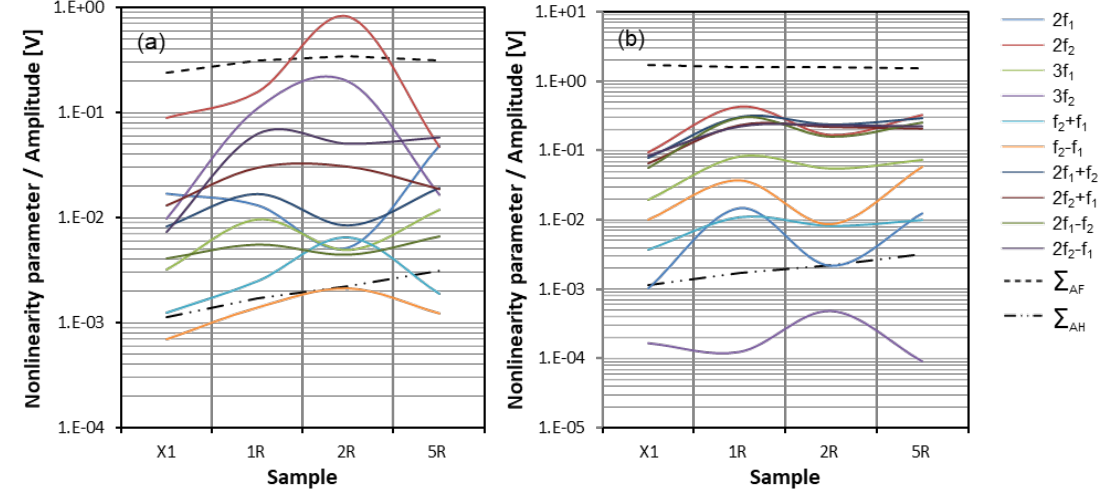
Figure 20. Nonlinearity parameter: ( a ) f 1 = 3 MHz, f 2 = 5 MHz, α = 60°; ( b ) f 1 = 4 MHz, f 2 = 5 MHz, α = 60°.